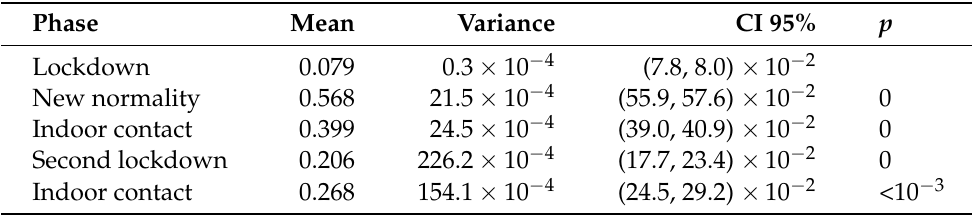
Table 15. Histogram for the mean values of β E at the different stages of lockdown in Italy.